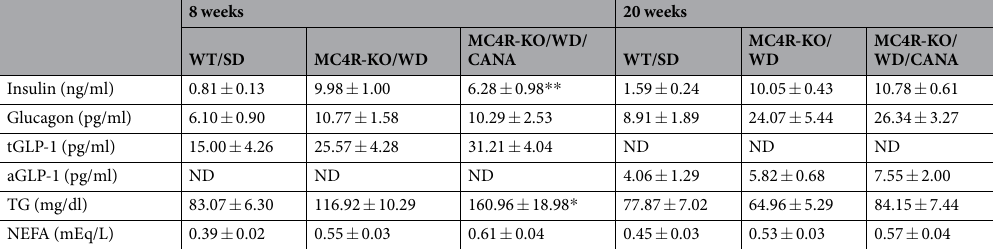
Table 1. Metabolic parameters of non-fasted WD-fed MC4R-KO mice after CANA treatment for 8 and 20 weeks. SD, standard diet; WD, western diet; CANA, Canagliflozin; tGLP-1, total GLP-1; aGLP-1, active GLP-1; TG, triglyceride; NEFA, non-esterified fatty acid. Data are mean ± SEM, * p < 0.05, ** p < 0.01 vs MC4R-KO/ WD; one-way ANOVA. n =